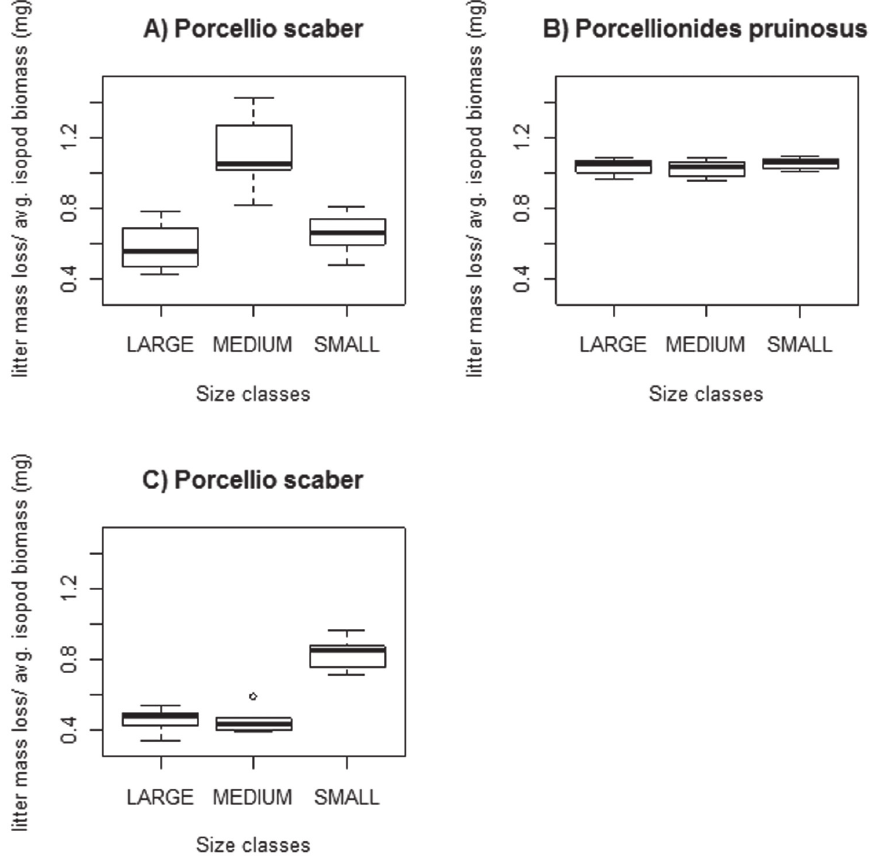
Figure 4. Freshly fallen poplar litter consumption of three size classes of Porcellio scaber and Porcellionides pruinosus . Legend: Thick line = median; box = lower and upper quartiles; whisker= min. and max values; open circles: